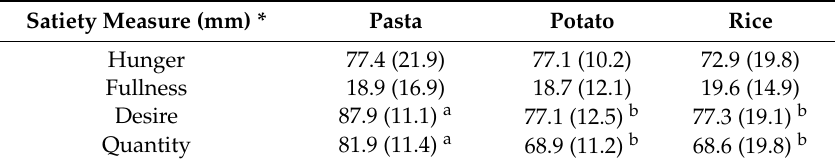
Table 2. Mean (SD) baseline satiety scores of 14